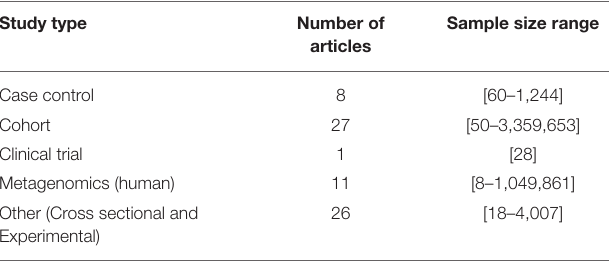
TABLE 1 | Summary of selected studies on gut microbiome and